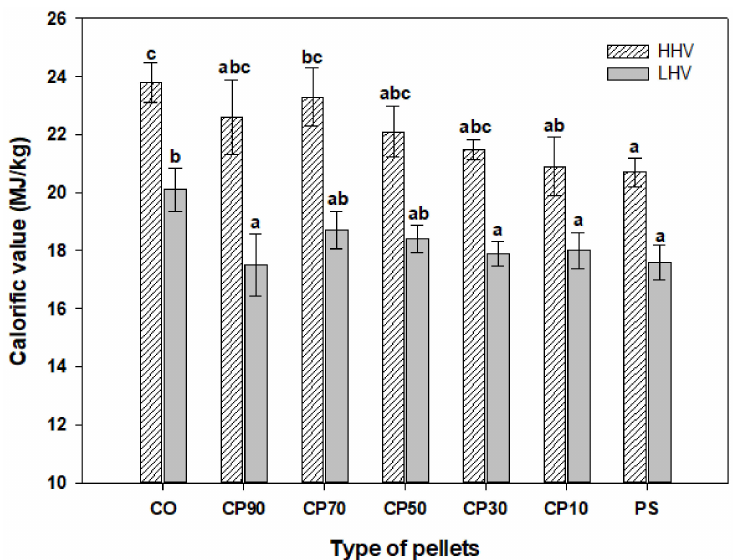
Figure 7. Pellet heating value according to SCG blending ratio. Each point is the mean of three repeated measurements and is the mean ± standard deviation. The means with different letters (a–c) above the bars indicate significant differences based on Tukey’s HSD test ( p <